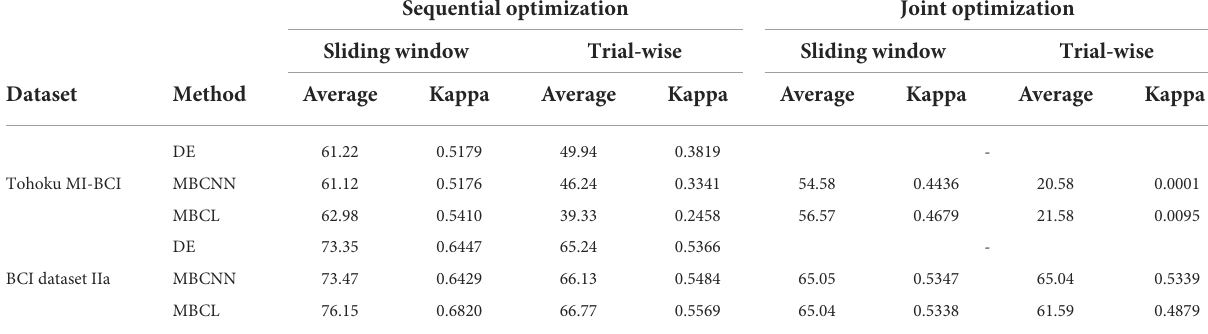
TABLE 4 Performance comparison of methods under different training